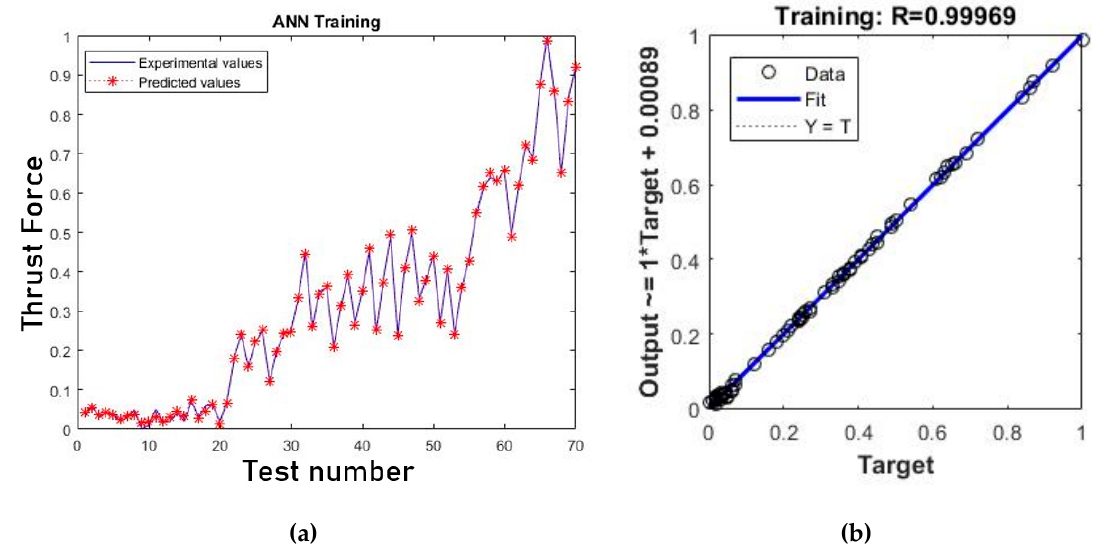
Figure 4. ( a ) Comparison between predicted and experimental values of normalized thrust force for the training pattern and ( b ) correlation analysis of the results.